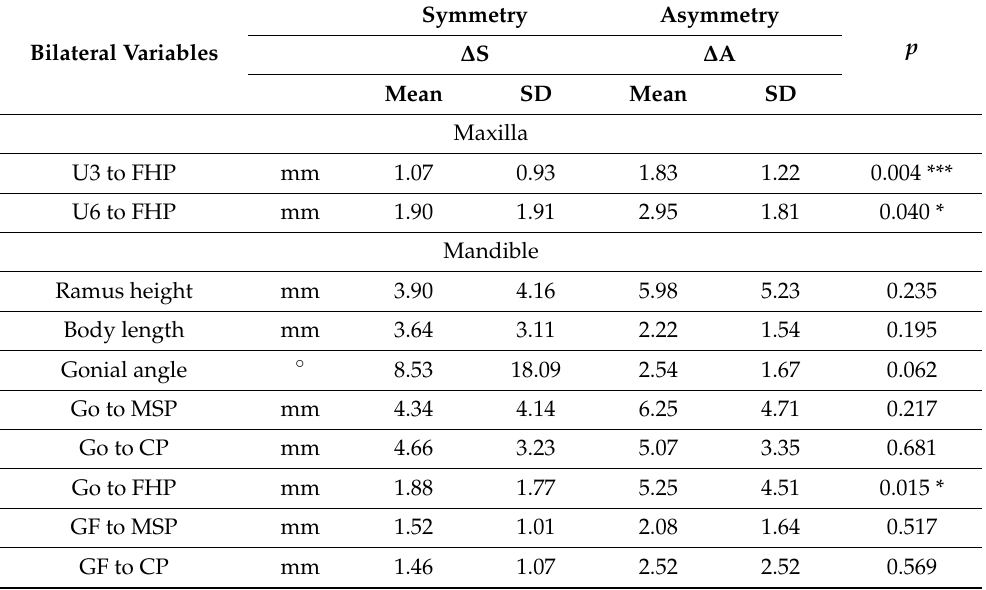
Table 4. Comparison of 3D preoperative (T0) measurements of bilateral variables between symmetry and asymmetry outcome